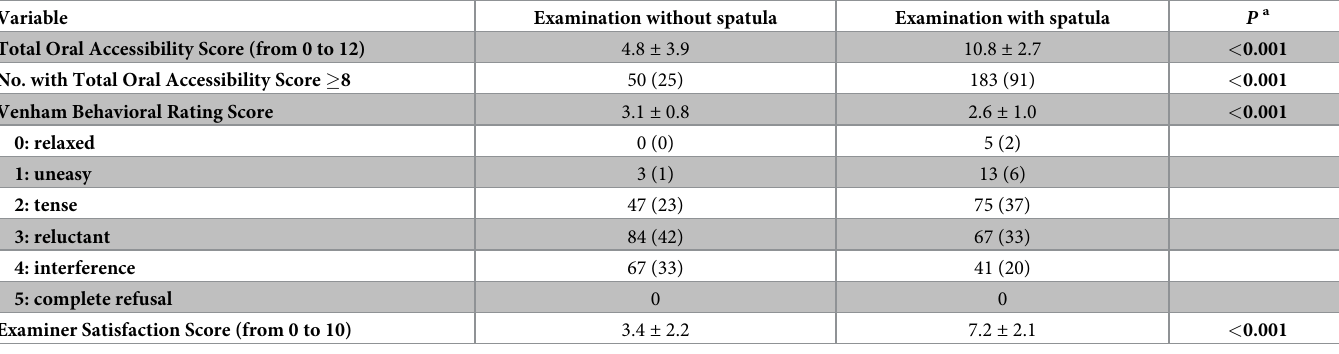
Table 2. Effect of the spatula on primary and secondary outcome variables ( n = 201).